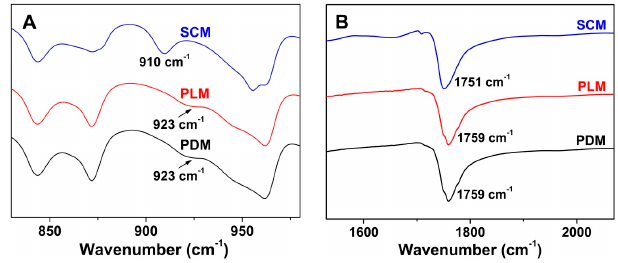
Figure 3. Crystallization peak variations of PDM, PLM, and SCM at ranges of 830–980 cm − 1 ( A ) and 1530–2070 cm − 1 ( B ).